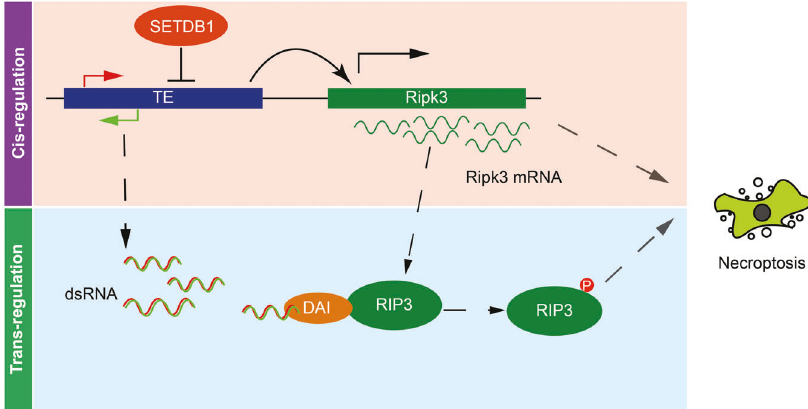
Fig. 7 ERVs activation results in cell necroptosis through cis and trans regulation. Activation of ERVs upstream Ripk3 enhances Ripk3 expression and cause necroptosis. ERVs produces dsRNA and cause necroptosis through ZBP1